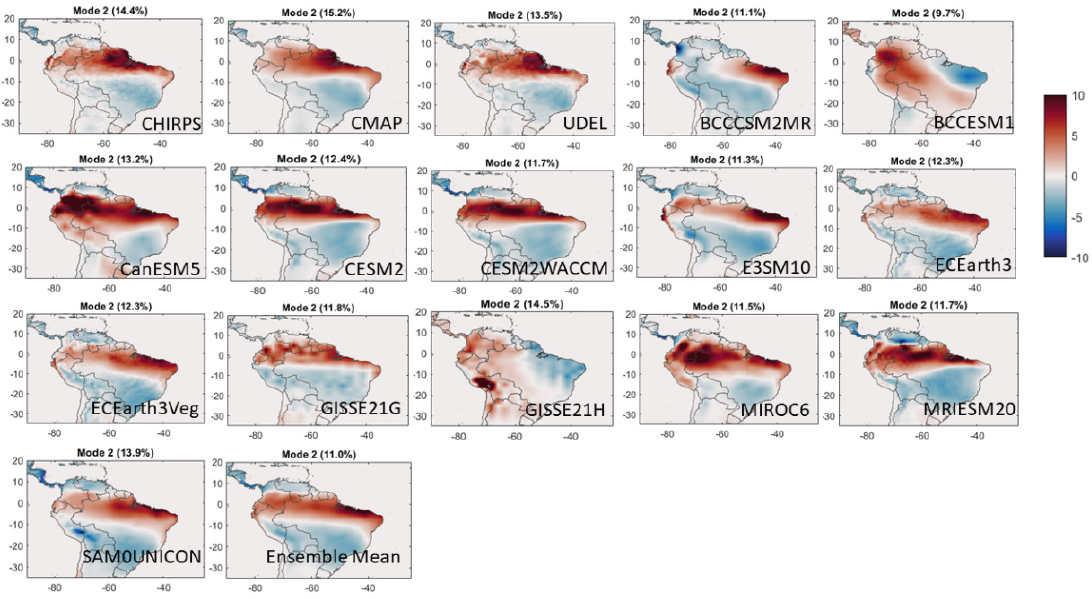
Figure 9. EOF eigenvector two for each dataset (1981–2014) with long-term mean removed.